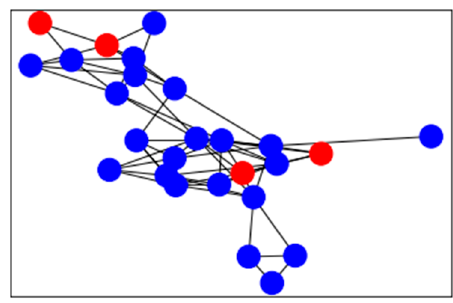
Figure 3. Card-to-card association network graph.